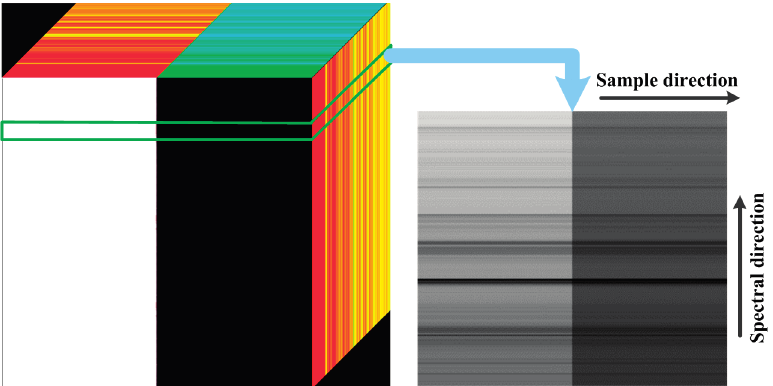
Figure 8. The imaging data. The left is a data cube, and the right is the spectral image for a line, which is not a standard edge image.